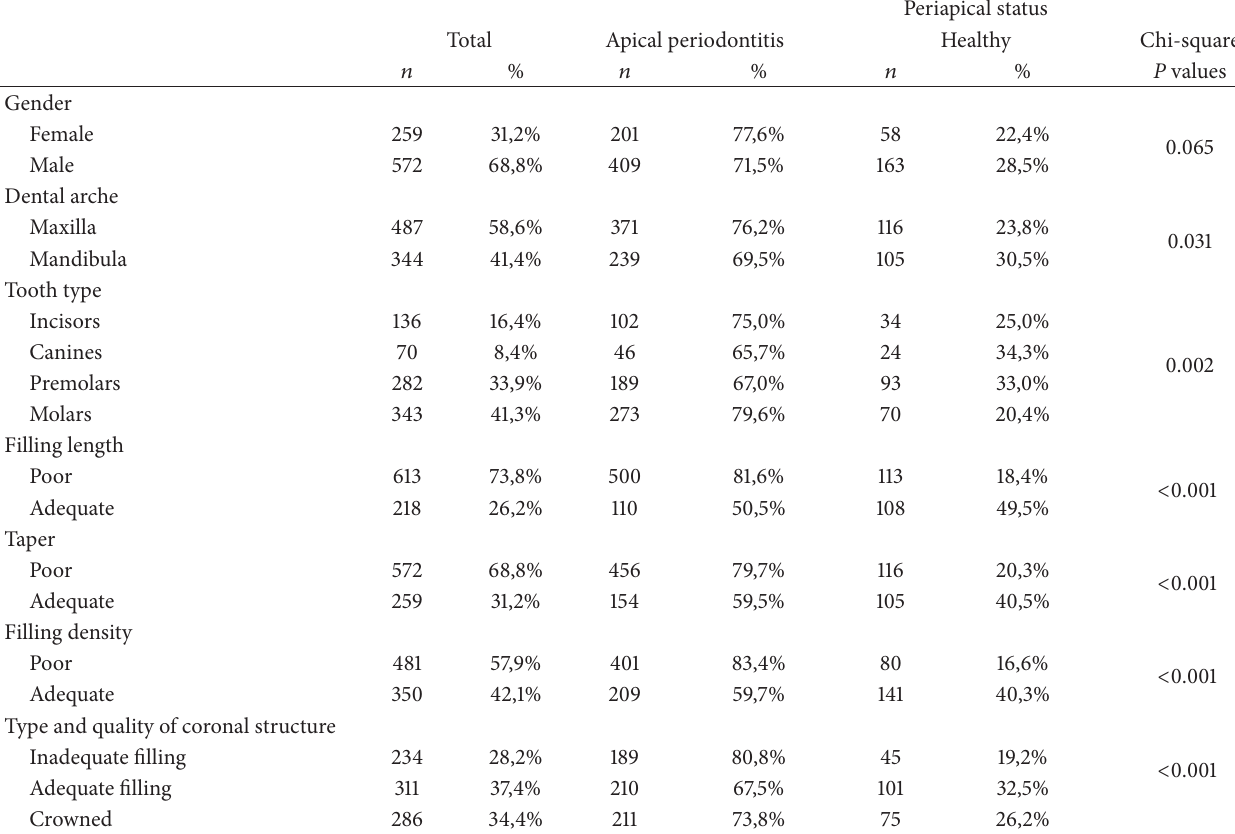
Table 2: Periapical status and related